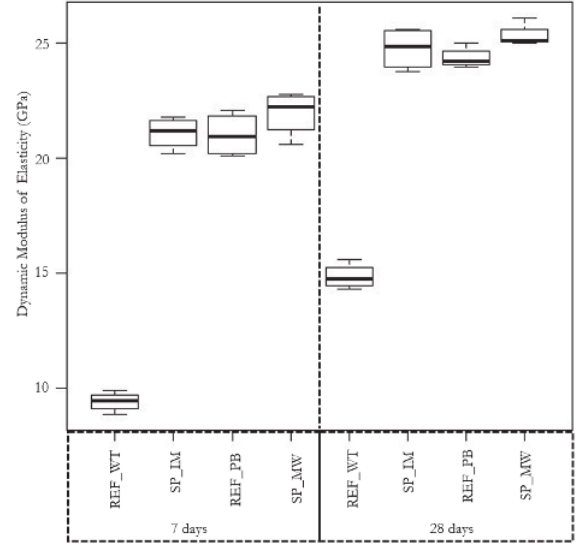
Figure 6 Dynamic modulus of elasticity of the mortars. Values are mean ± SD (n =